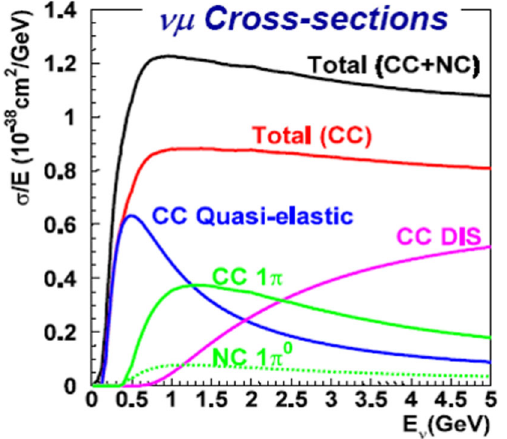
Fig. 40 A schematic representation of various channels of low energy neutrino interactions by the neutrino interaction model NEUT. Above 1 GeV, a large fraction of interactions are inelastic interactions